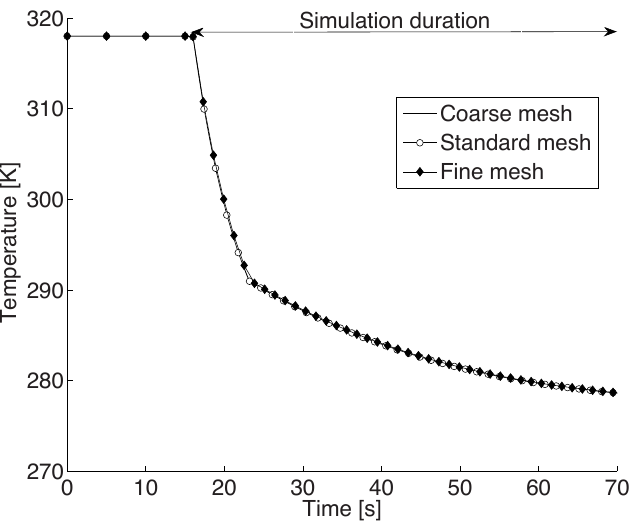
Figure 2. Temperature profile of a 2 mm droplet, initially at 318 K, suspended in a chamber that is at 277 K and 1 bar, using three different mesh